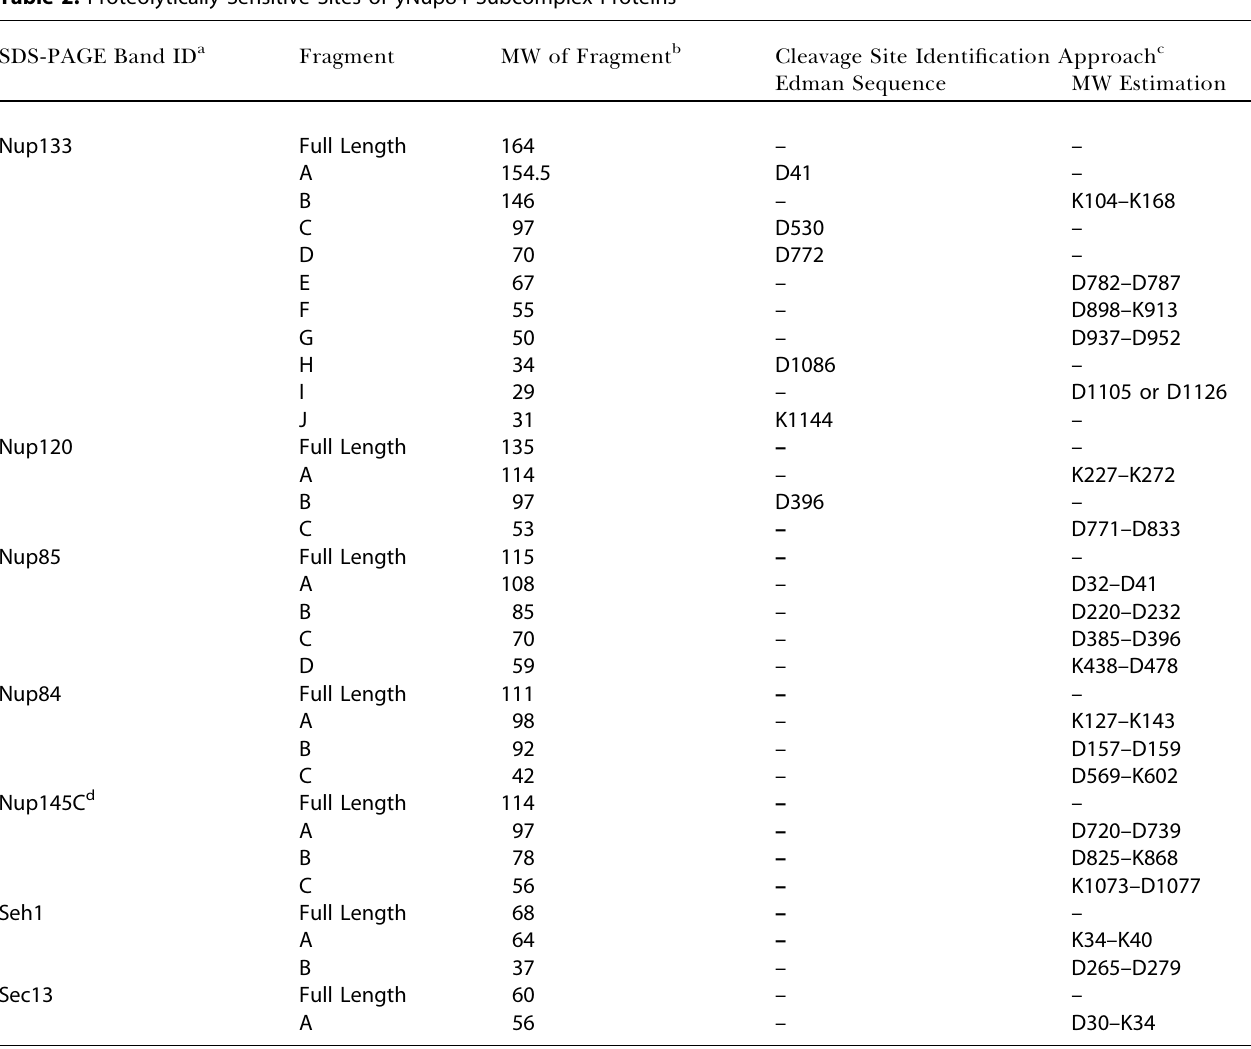
Table 2. Proteolytically Sensitive Sites of yNup84 Subcomplex